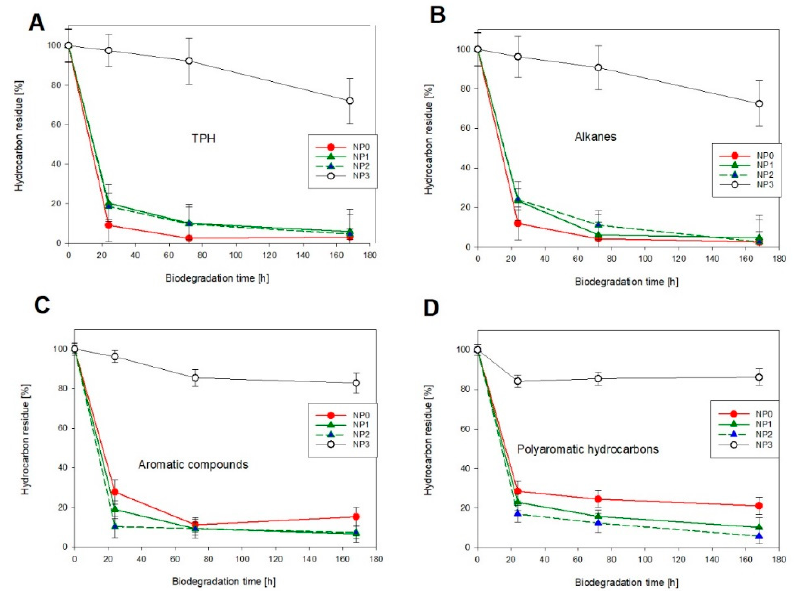
Figure 1. Biodegradation kinetics of selected hydrocarbon fractions: TPH ( A ), alkanes ( B ), aromatic compounds ( C ), and PAH ( D ) in the experimental variants.